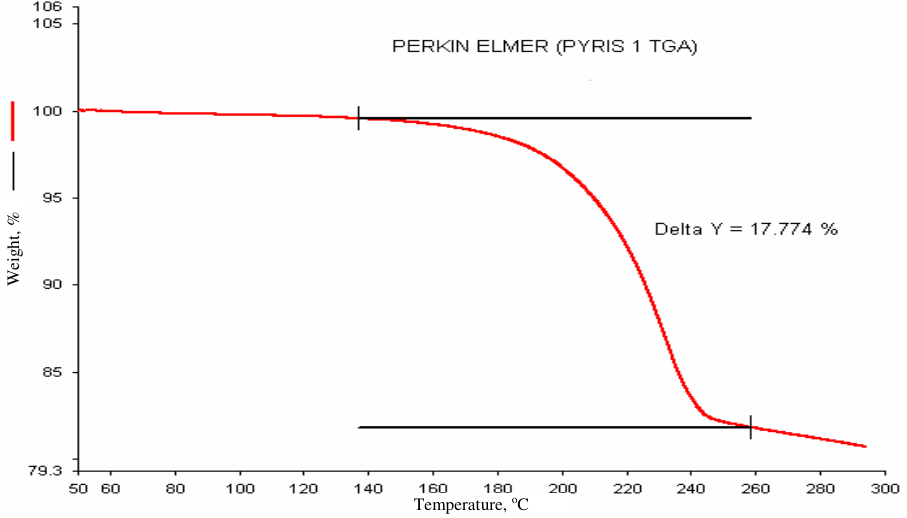
Figure 1 . Thermogram of